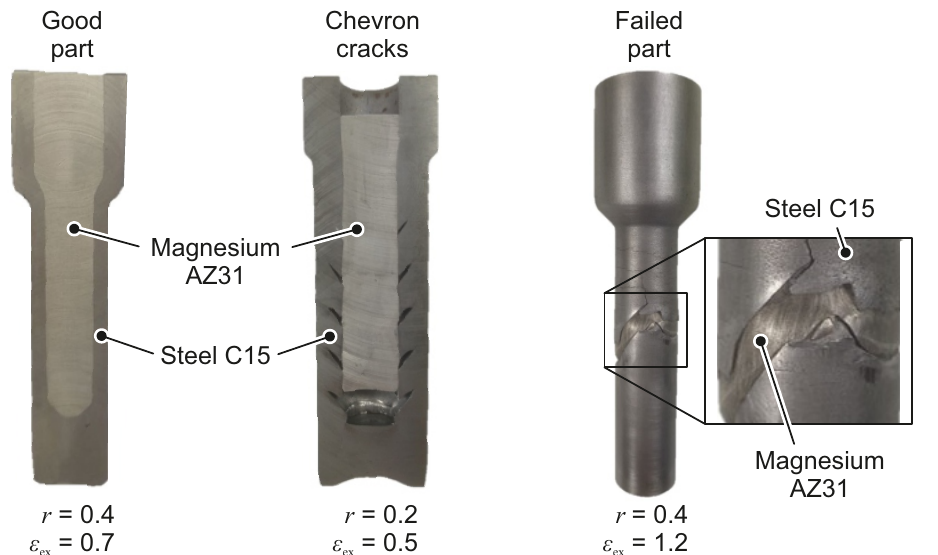
Figure 5. Parts produced by magnesium-steel composite forward rod extrusion. For high extrusion strains and high area reductions, macroscopic cracks over the entire sheath thickness are observed. These defects occur during ejection after forward rod extrusion, as no force drop is observed during the forward rod extrusion process. As ejector forces increase and the cross sectional area of the shaft decreases for higher extrusion strains, the shaft is more prone to upsetting during ejection. This is especially the case for low sheath wall thicknesses, which is why this type of failure is promoted by the use of steel cups with high reduction ratios.